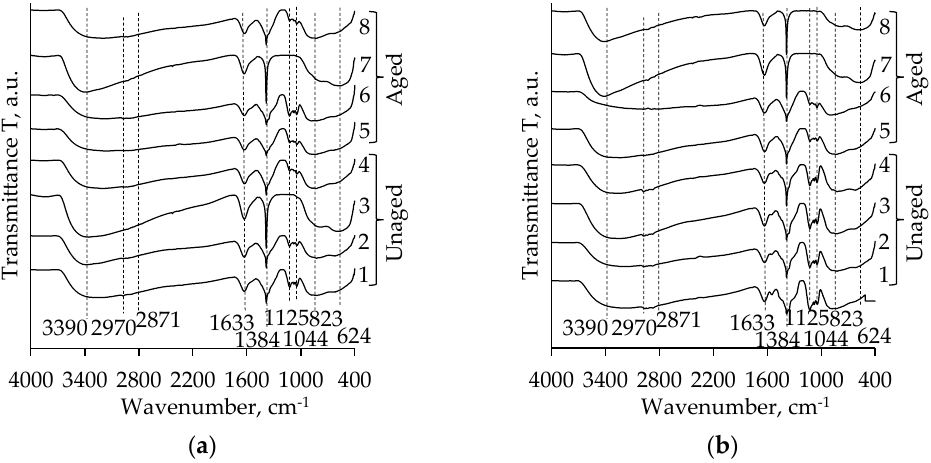
Figure 3. FT-IR spectra of TiO 2 aerogels after subcritical drying without aging ( 1 – 4 ) and after 72 h aging ( 5 – 8 ) in dependence of precursor type (TIP ( a ), TBOT ( b )) and solvent used for additional solvent exchange ( 1 , 5 —without exchange; 2 , 6 —CH; 3 , 7 —nH; 4 , 8 —DE).